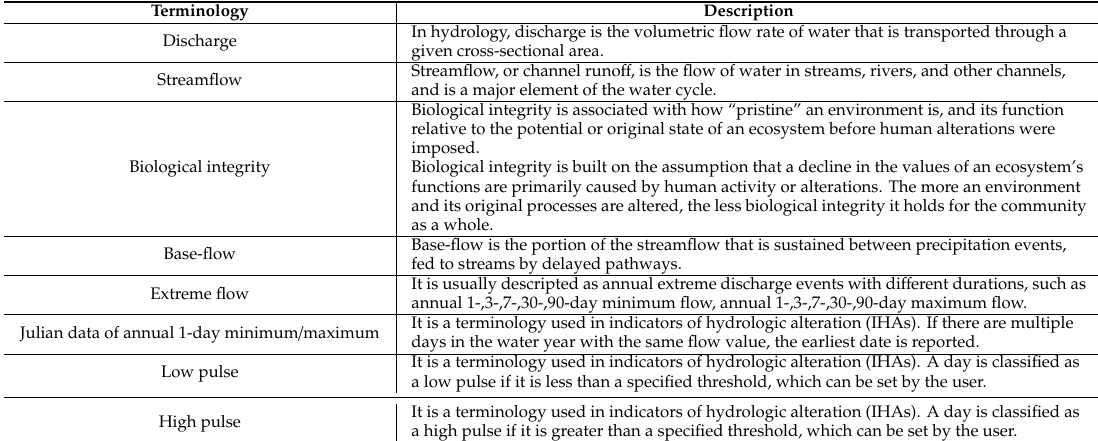
Table A1. Some terminology and the